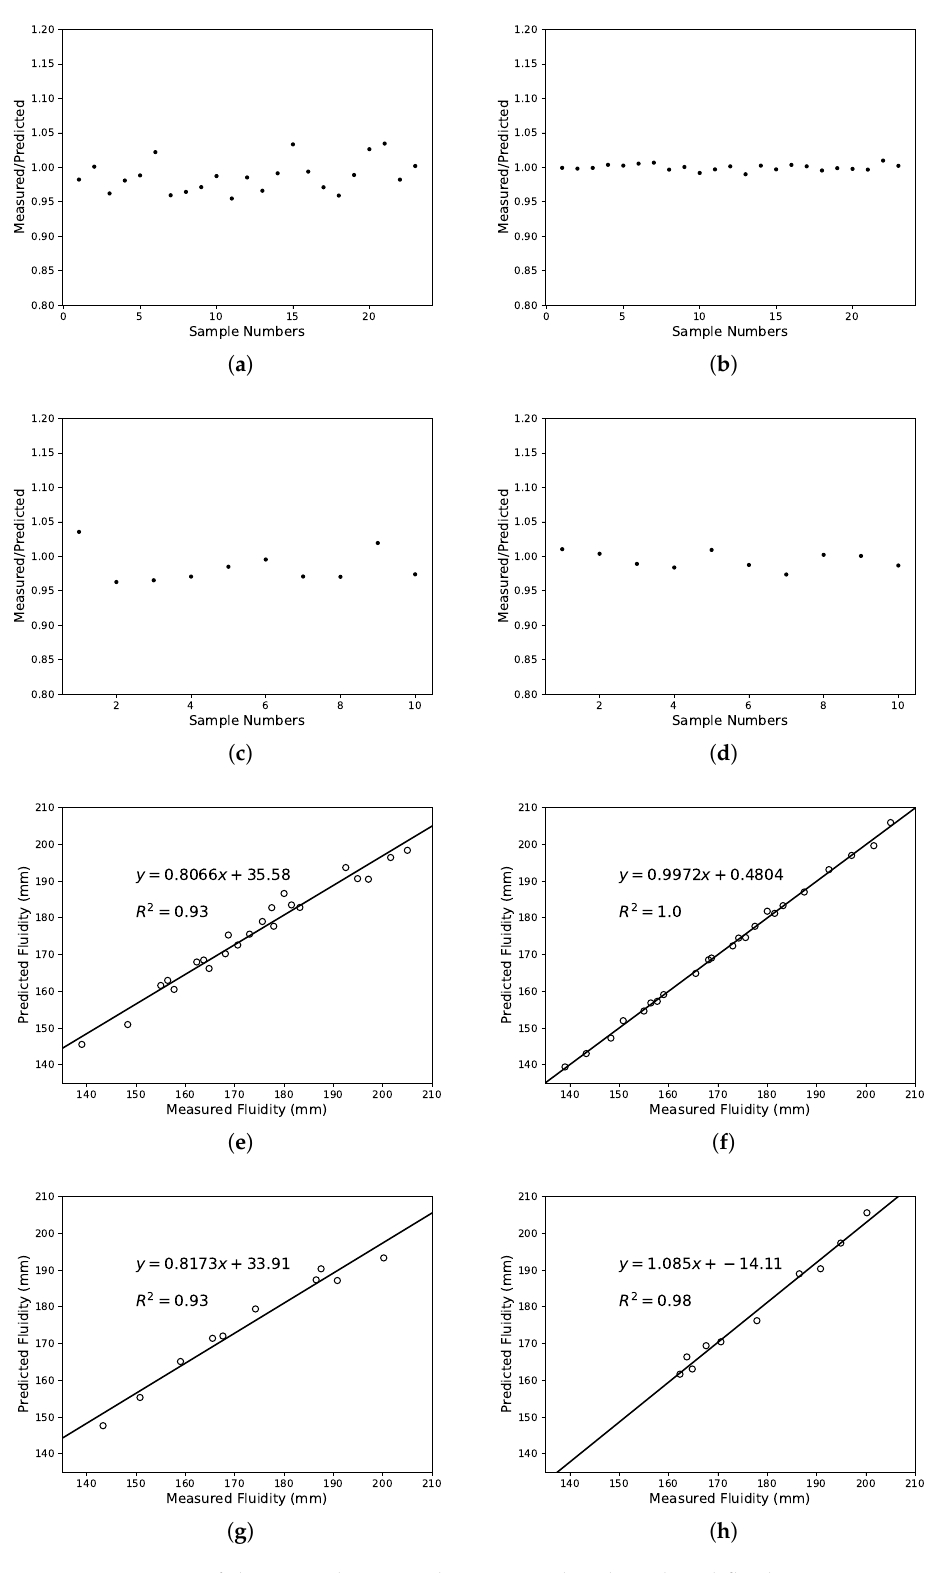
Figure 7. Comparison of the ration between the measured and predicted fluidity using SVM and LS-SVM. The ratio: ( a ) SVM in training set, ( b ) LS-SVM in training set, ( c ) SVM in test set, ( d ) LS-SVM in test set; The correlation: ( e ) SVM in training set, ( f ) LS-SVM in training set, ( g ) SVM in test set, ( h ) LS-SVM in test set.